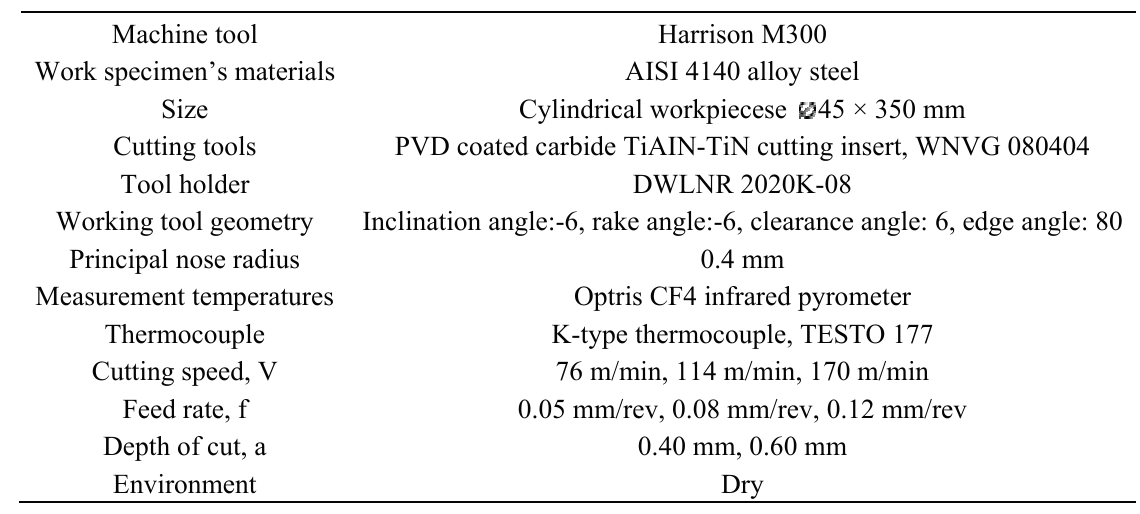
Table 1. Experimental conditions.